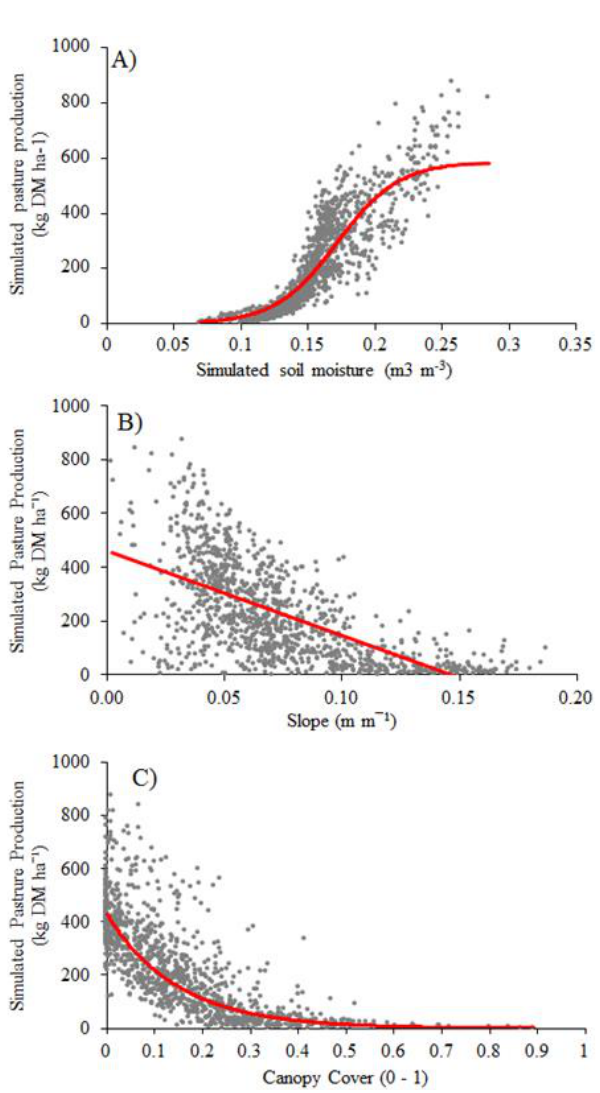
Fig. 11. Scatter plot between average pasture production simulated and (A) average soil moisture simulated, (B) slope, and (C) canopy